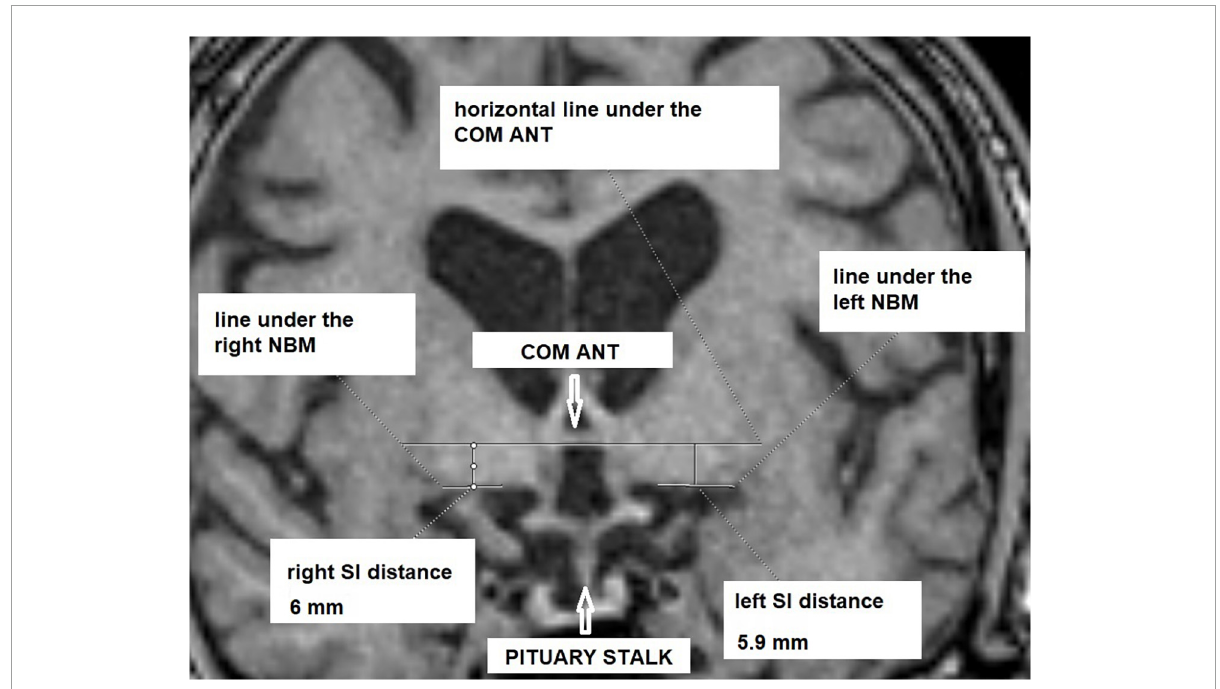
FIGURE1 Measurement example. COM ANT, commissura anterior; SI, substantia innominata; NBM, nucleus basalis of